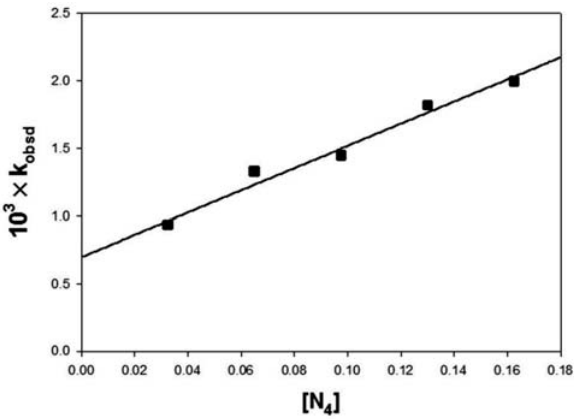
vs. teazma for Cu(bcen)(NO obsd